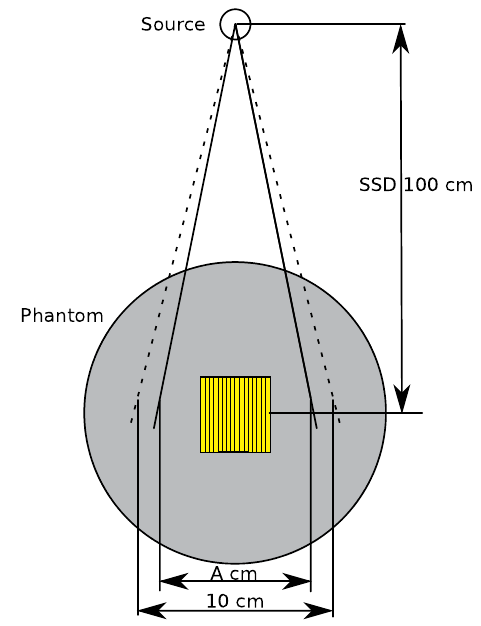
FIG. 6. Illustration of the output factor measurements in the cylindrical phantom. The segmented rectangle inside the phan- tom indicates the position of the detector’s active area.